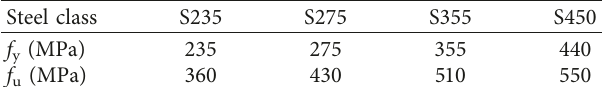
Table 5: Parameter study (steel